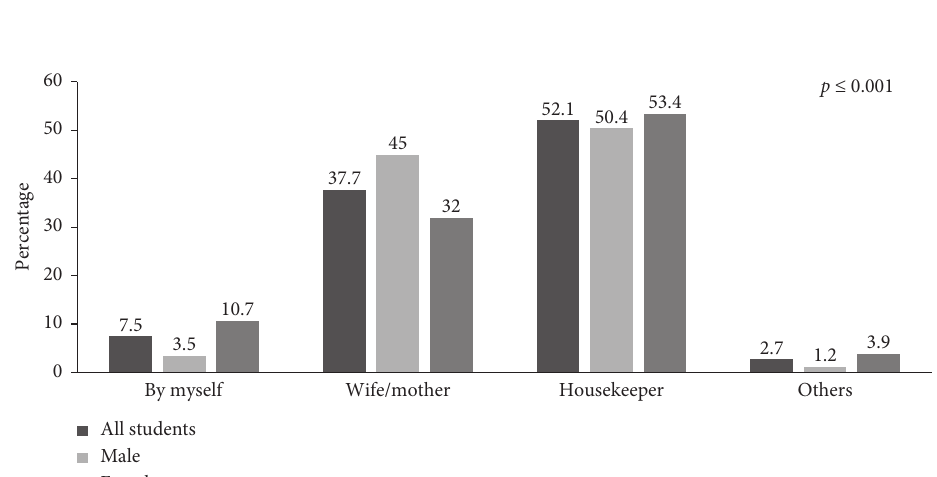
Figure 2: Cooking habits among study participants.